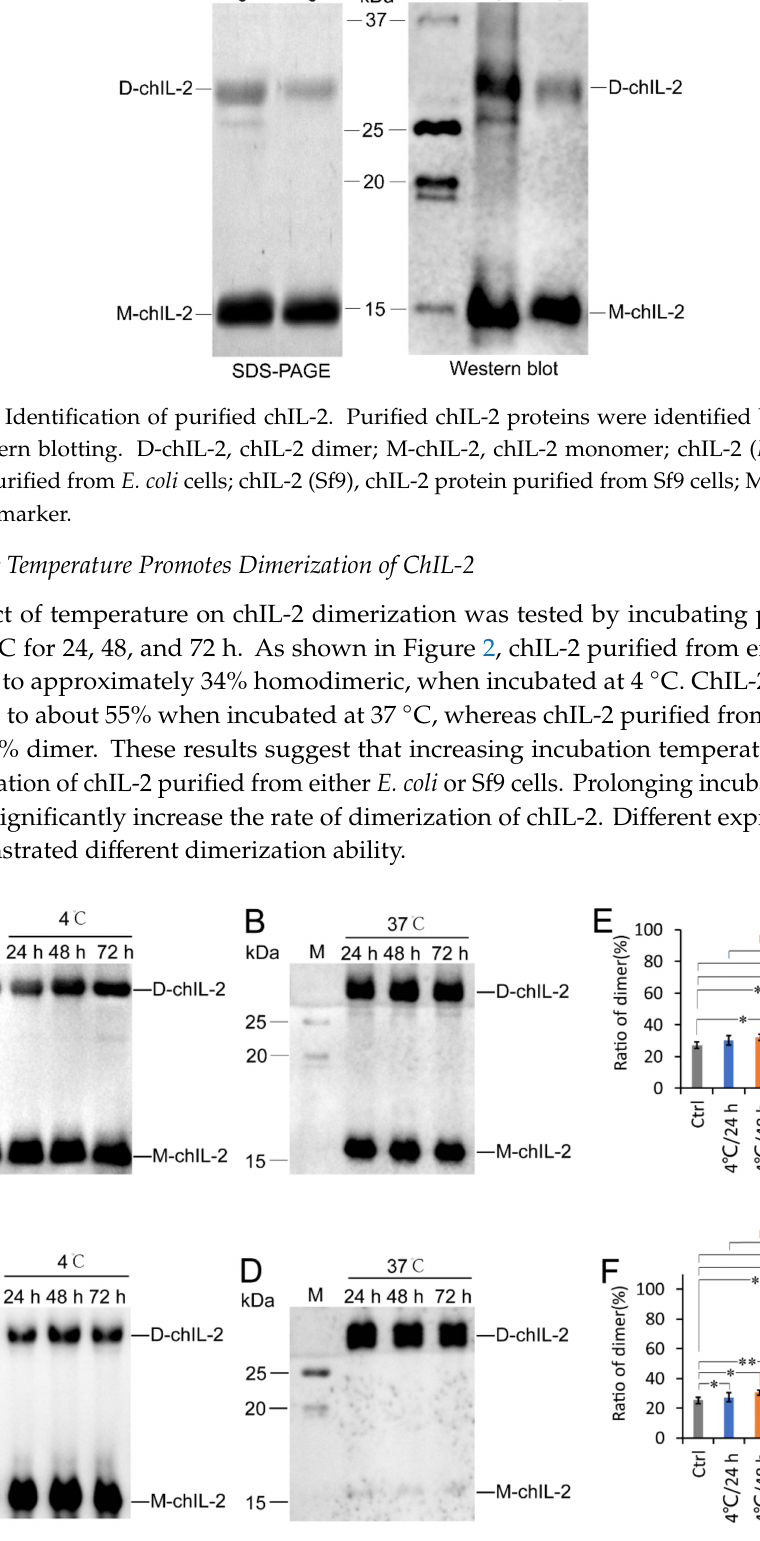
Figure 2. E ff ect of temperature on chIL-2 dimerization. ( A ), ( B ), ( C ) and ( D ) are western blot images